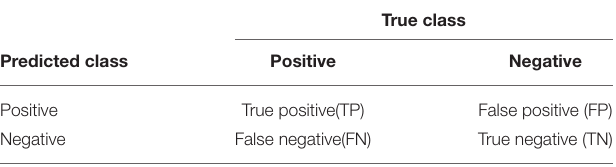
TABLE 3 | Relationship between predicted class and true class.